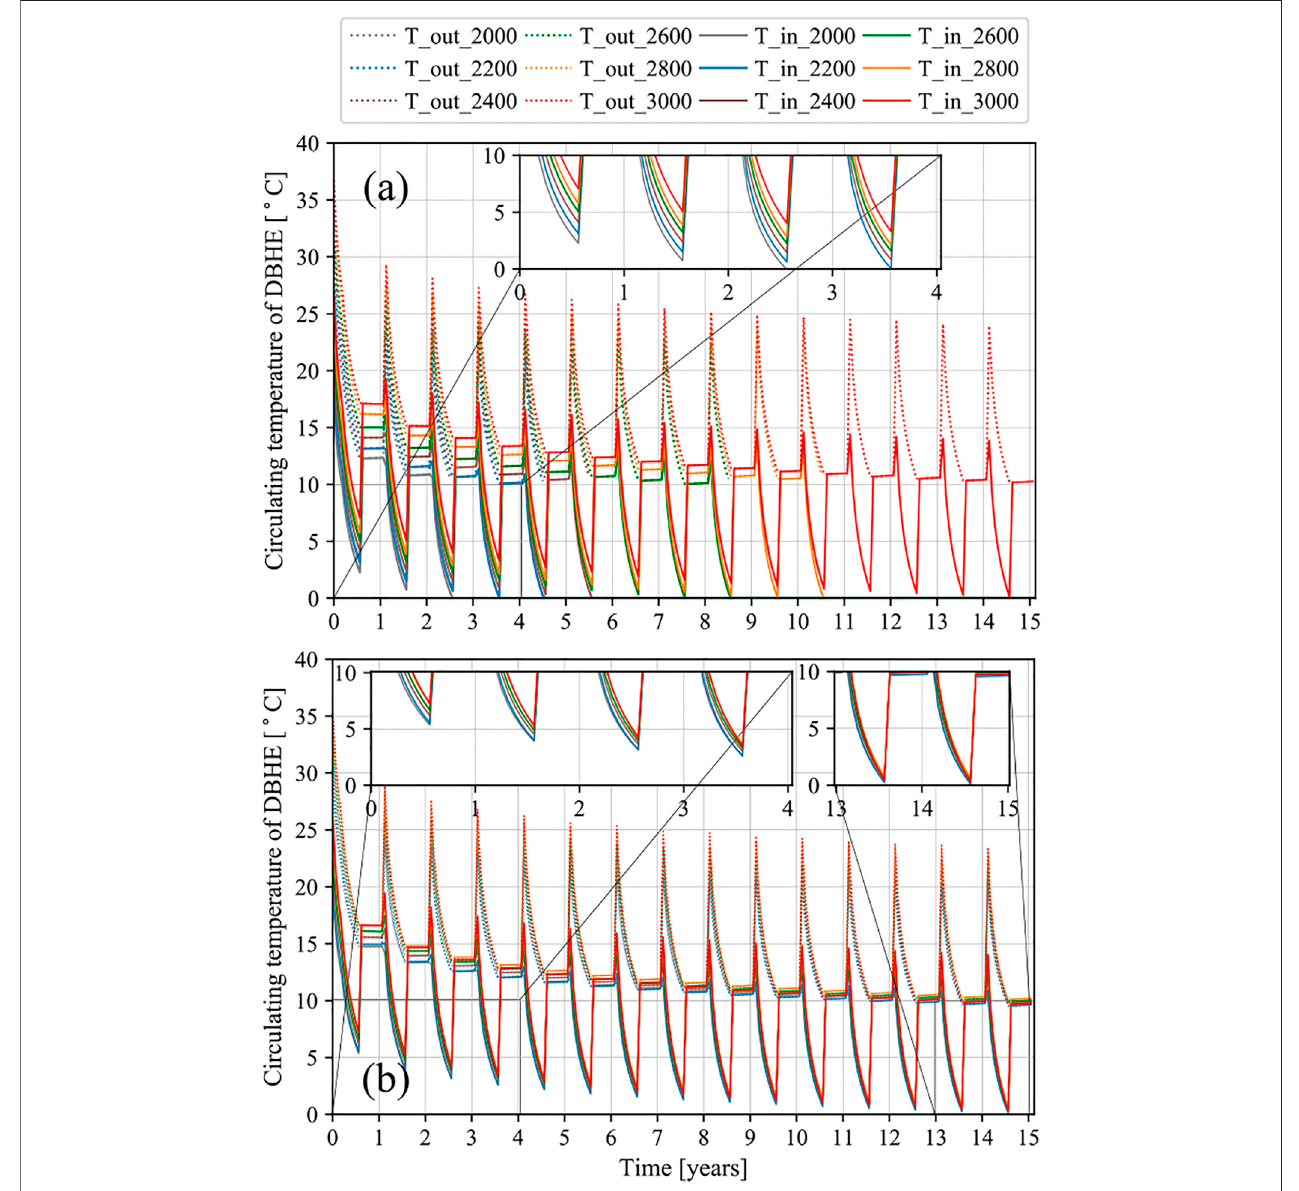
FIGURE 4 | Long-term heat extraction performance of the DBHE (A) with the tentative heat extraction capacity (B) with the adjusted heat extraction capacity.